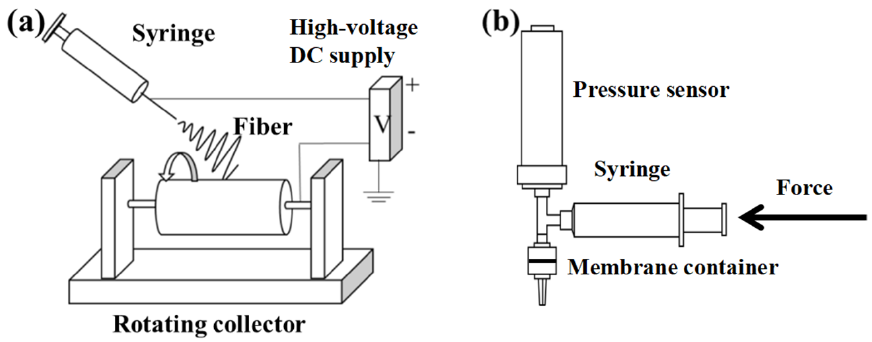
Figure 1. Schematic diagrams of the electrospinning process with a rotating drum collector ( a ) and a hydraulic permeability test unit ( b ).